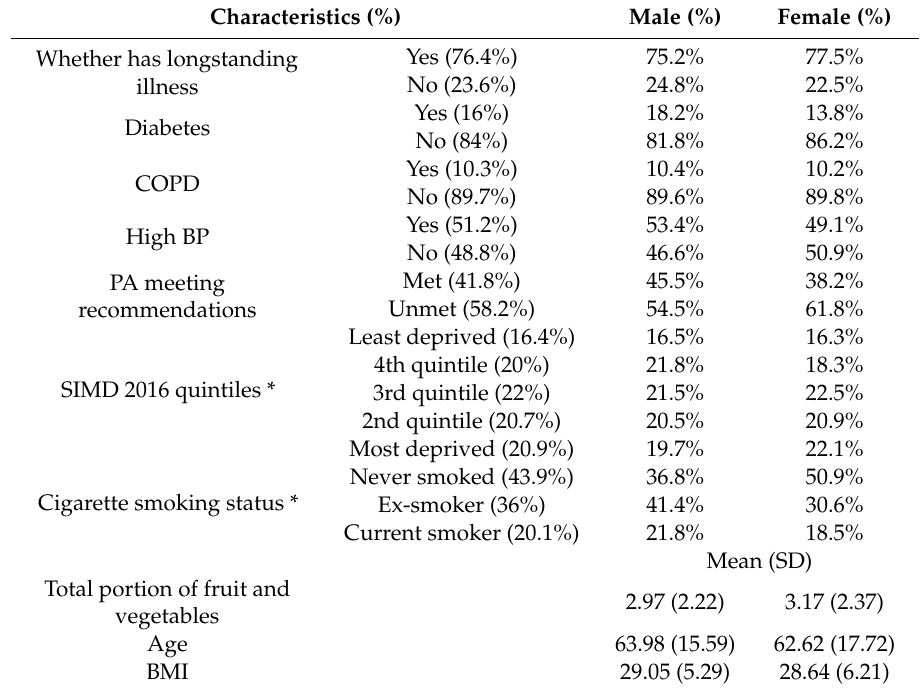
Table 1. Baseline